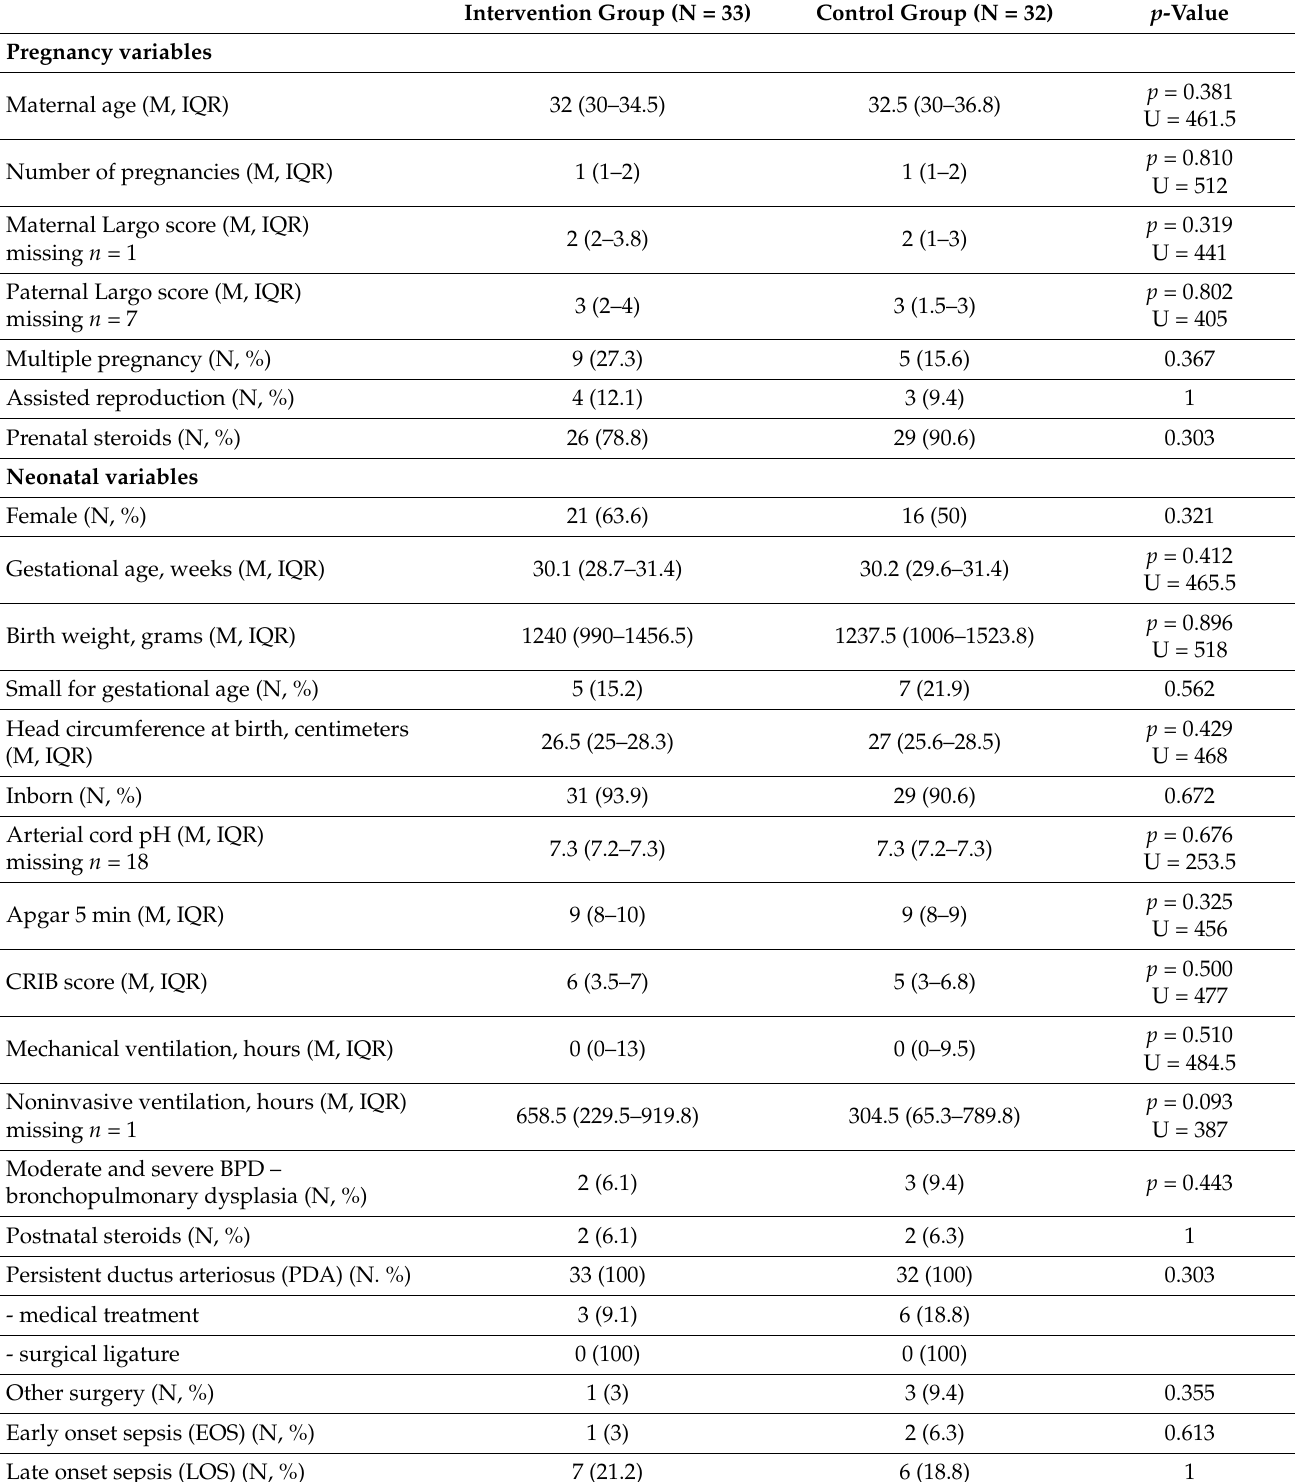
Table 1. Pregnancy and neonatal